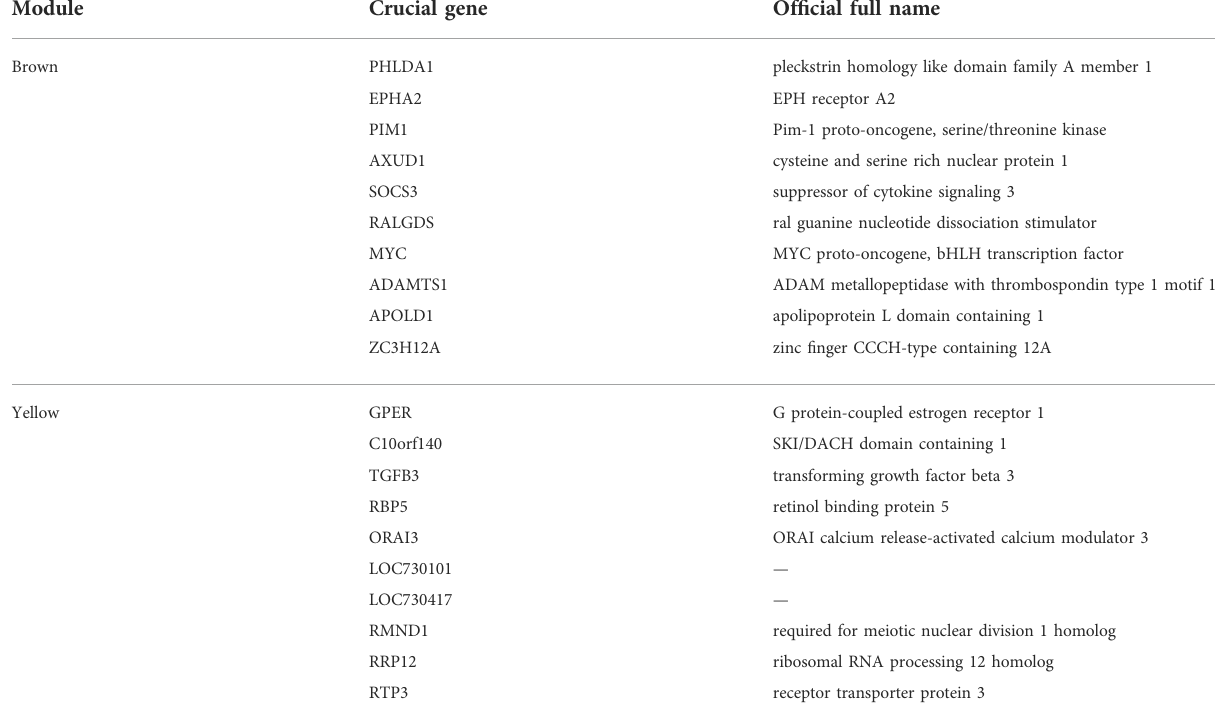
TABLE 1 Crucial genes for the brown and the yellow module.